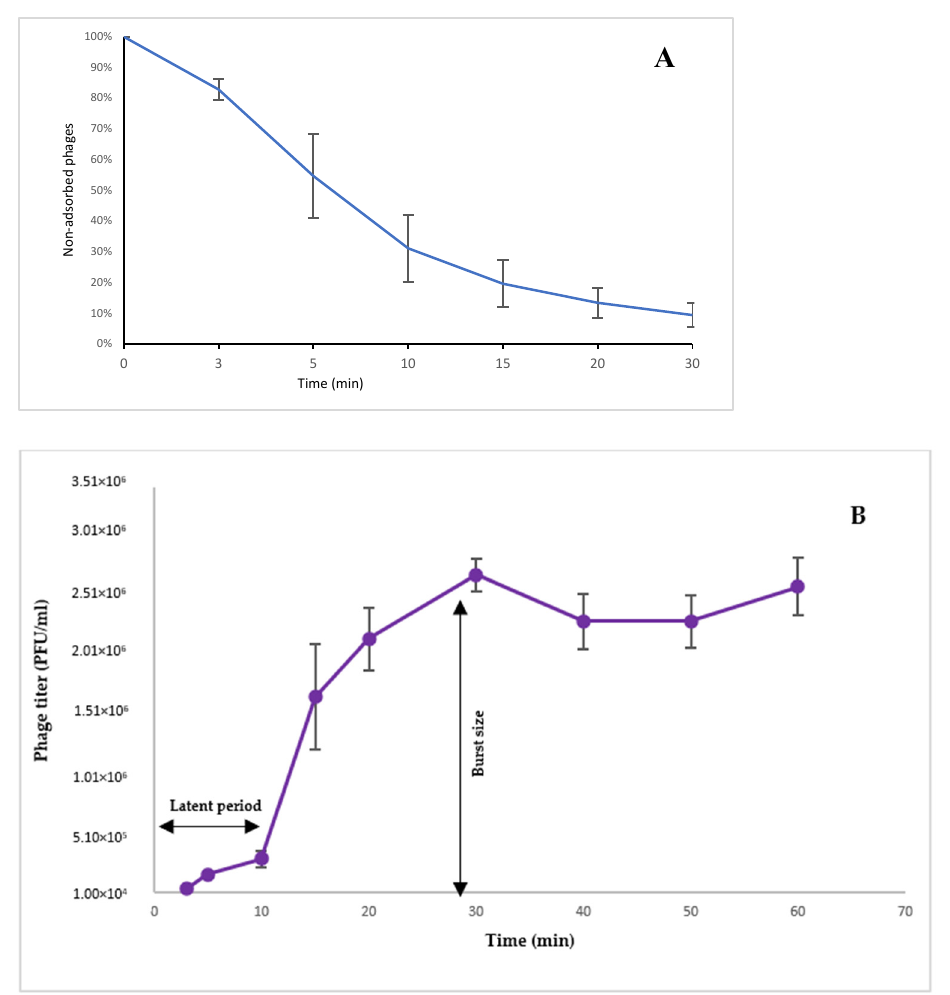
Figure 5. Physiological parameters of phage Ps12on-D. ( A ) The adsorption rate is K = 1.34 × 10 − 9 ml/min of phage Ps12on-D. Phages were mixed with excess P. aeruginosa strain CN573, and the non- adsorbed infectious phages were serially counted. Data are percentages of non-adsorbed Ps12on-D relative to the initial input dose of phages. ( B ) One-step growth curve of P. aeruginosa phage Ps12on-D on host strain CN573. The latent period is calculated after adsorption. The presented data are means of three independent experiments with error bars showing the standard error of the mean (SEM).